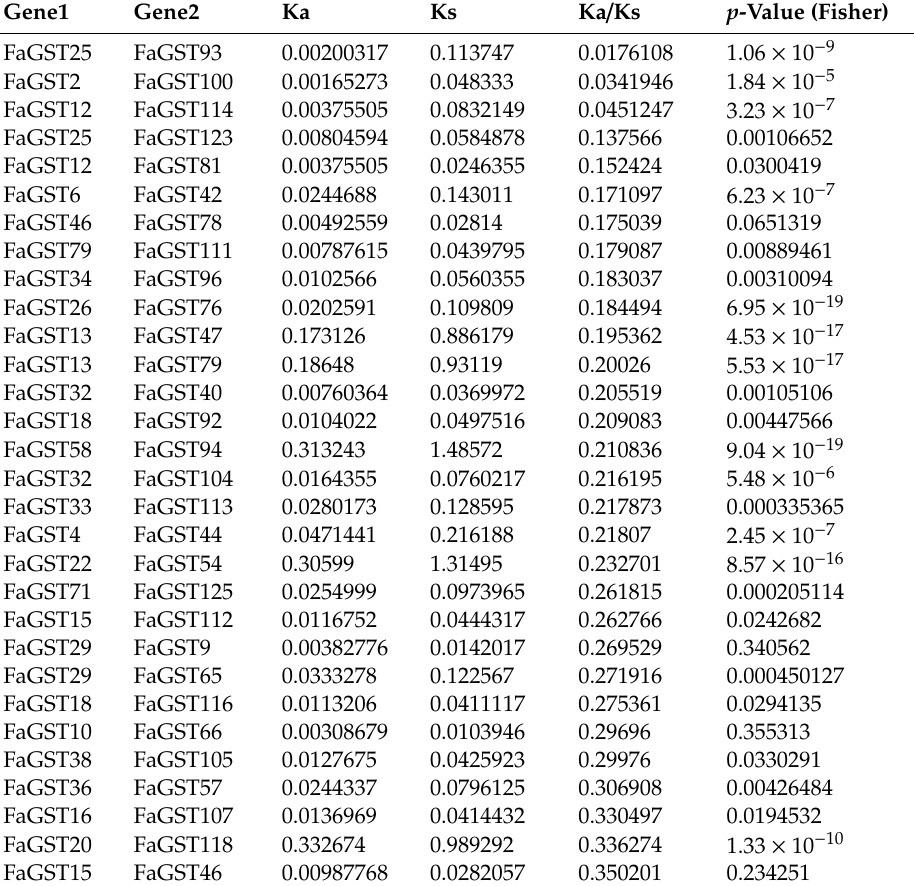
Table 1. Ka / Ks of glutathione S-transferase ( GST ) paralog genes from cultivated strawberry. Gene1 Gene2 Ka